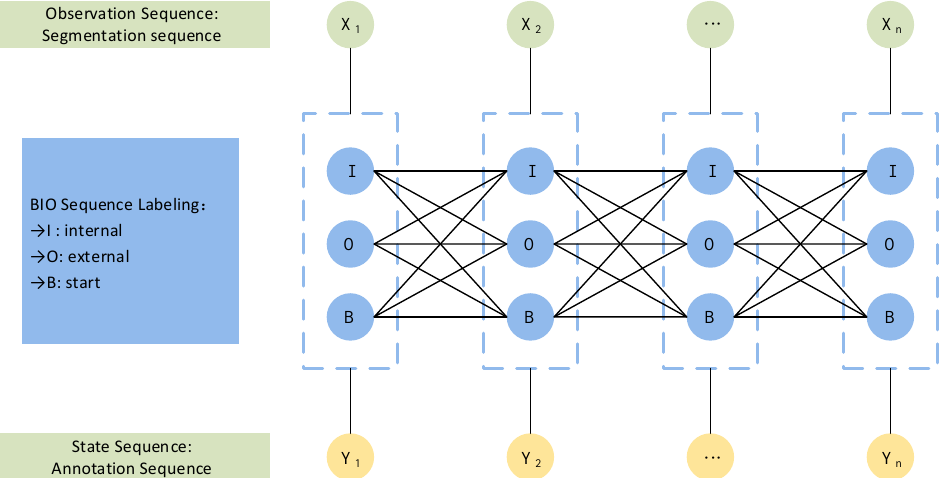
Figure 2. Working principle of the BIO sequence labeling task. The sequential tagging task can select the labeling result with the highest overall probability among all possible labeling results, and the probability of each item is the sum of the output probability of the upper layer and the labeling conversion probability. This method can not only obtain the overall optimal solution, but also avoid the situation where the answer is